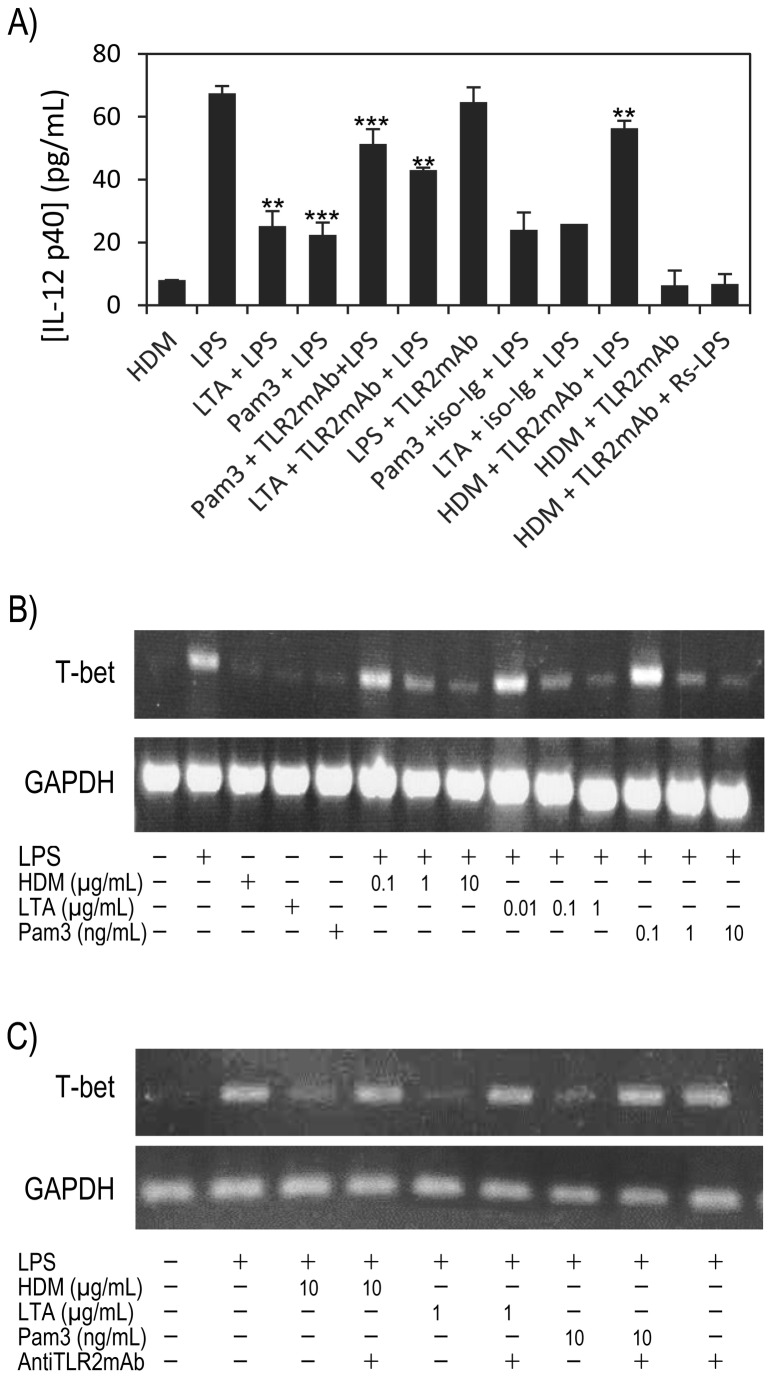
HDM extract prevents LPS-induced expression of Th1-immune response factors in MH-S cells through a TLR2 dependent mechanism.(A) Inhibition of the LPS-stimulated induced MH-S cells IL-12 production by the TLR2 agonists (see legend figure 5 for experimental details; statistical analysis was performed using Student’s t-test; ** p<0.01; *** p<0.005). (B) HDM extract inhibition of LPS-induced T-bet expression in MH-S cells. MH-S cells were treated as above except that T-bet expression was evaluated by RT-PCR amplification at 2h and 6h post LPS addition. (C) Suppression by TLR2 antibodies of the inhibitory effect of the TLR2 ligands on the LPS induced T-bet expression (TLR ligands are used at the higher inhibitory concentration tested in B).